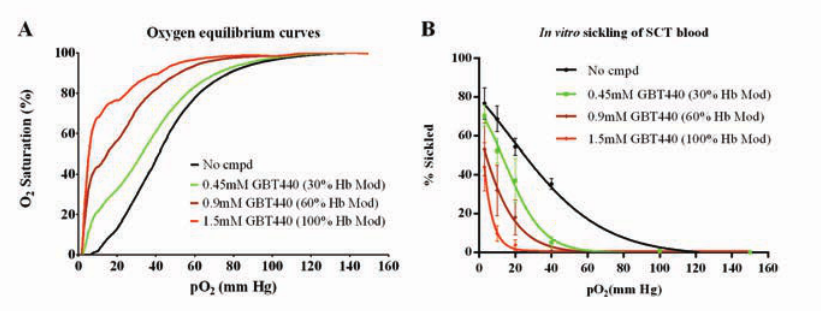
Figure 5. GBT440 inhibits in vitro sickling of sickle cell trait (SCT) red blood cells (RBCs) under conditions mimicking a combination of hypoxia, dehydration and acido- sis. A) Oxygen equilibrium curves (OECs) of SCT blood treated with varying concen- trations of GBT440 in hypertonic phosphate buffer, pH 6.9. B) Percentage of sickled SCT RBCs at the indicated oxygen tensions corresponding to the OECs in (A). Mean and standard error of mean shown for n=3 SCT